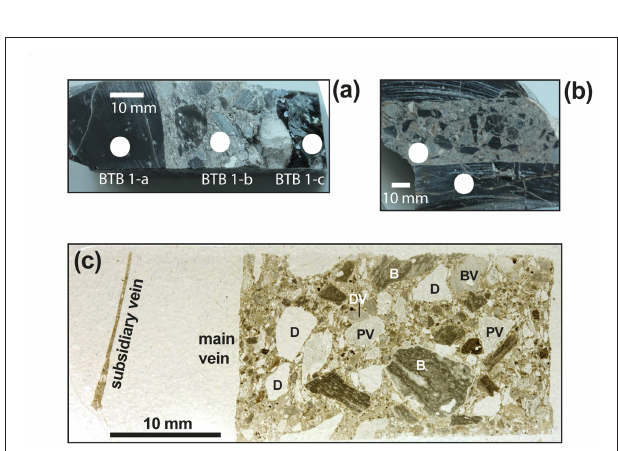
FIGURE 2 | Location of analyses within samples BTB fragment 1 (A) and 2 (B). White dots indicate the location of bulk density and porosity measurements. (C) Scanned image of the analyzed thin section, showing some principal clast types in the main vein (PV, pale vesicular; DV, dark vesicular; BV, borderless vesicular; D, dense; B, banded), and the thinner subsidiary